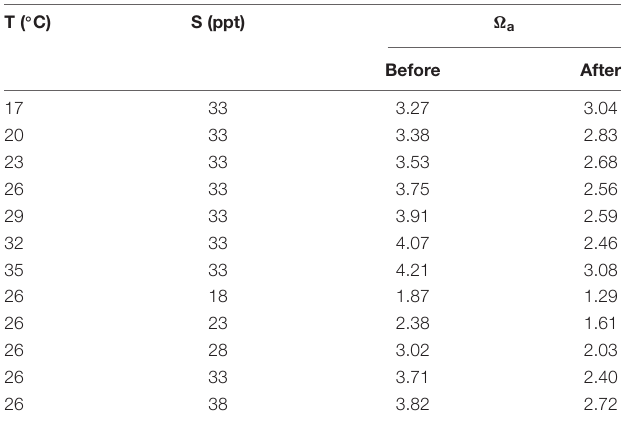
TABLE 2 | Saturation states of the water related to aragonite minerals ( (cid:127) a ) before and after the physiological experiment with different temperatures (T) and salinities